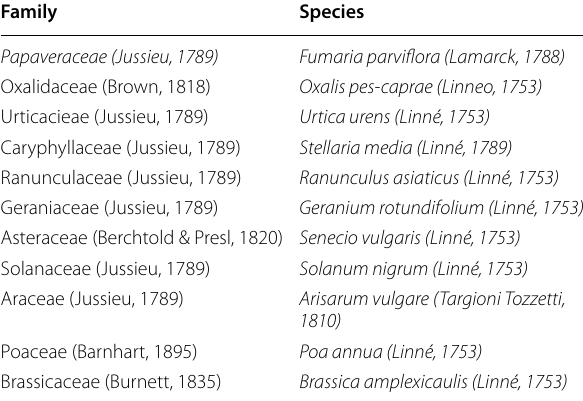
Table 3 Botanical species identified in the three study sites Family Species